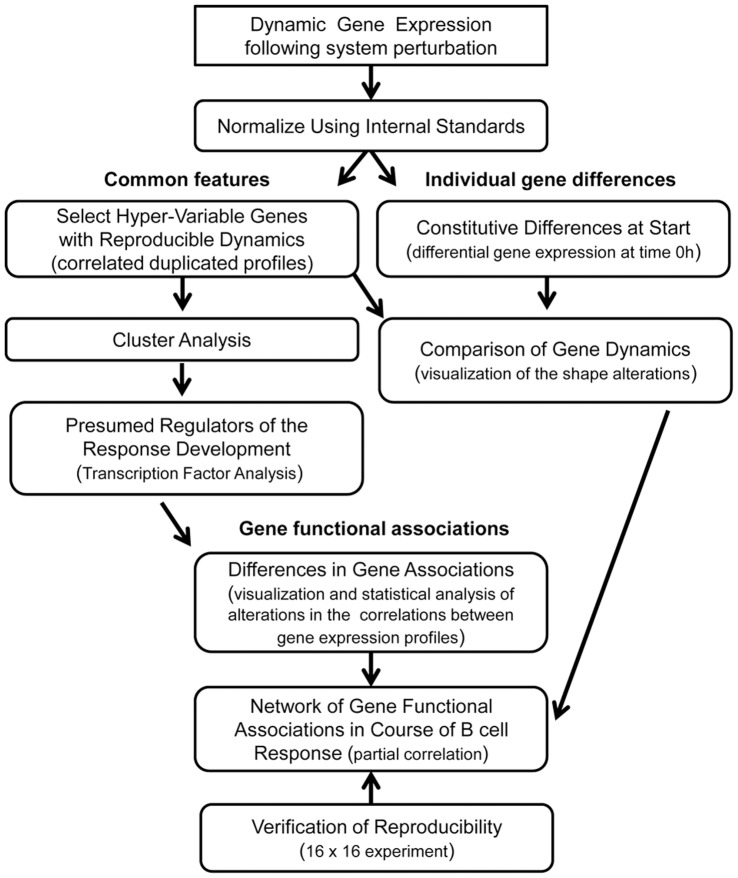
Schematic of pathway dysregulation analysis.The self-verified experimental design of pathway dysregulation analysis is depicted.